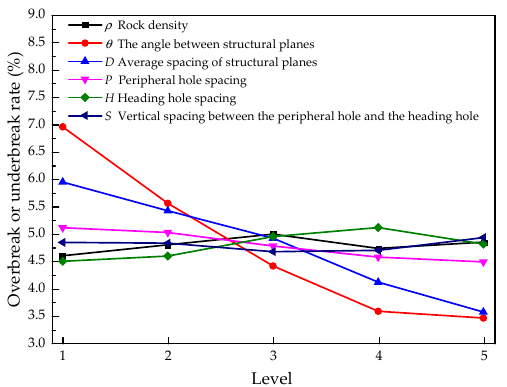
Figure 12 . Overbreak or underbreak rate of smooth blasting under different levels of each factor in the massive structure rock mass. the massive structure rock